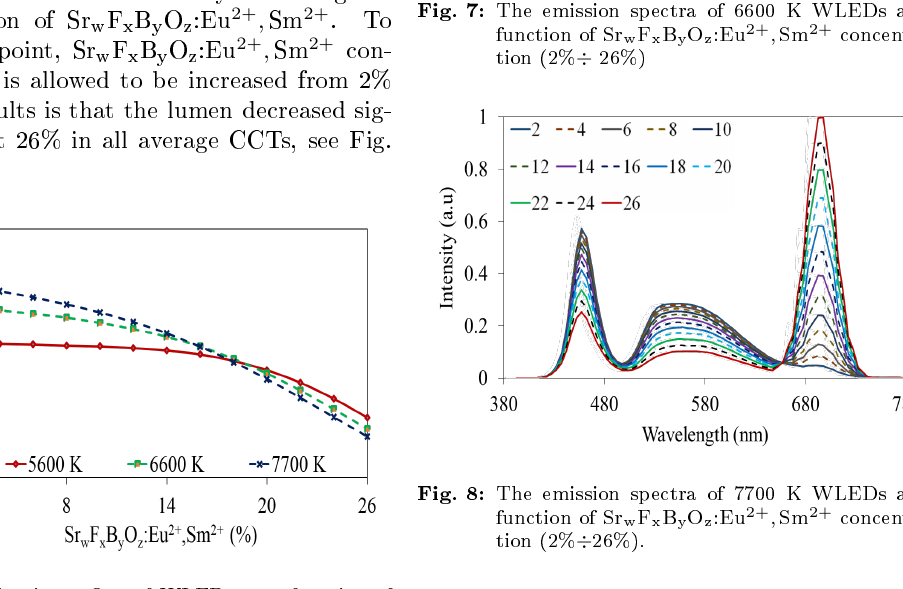
Fig. 5: The luminous (cid:29)ux of WLEDs as a function of Sr w F x B y O z :Eu 2+ , Sm 2+ concentration.